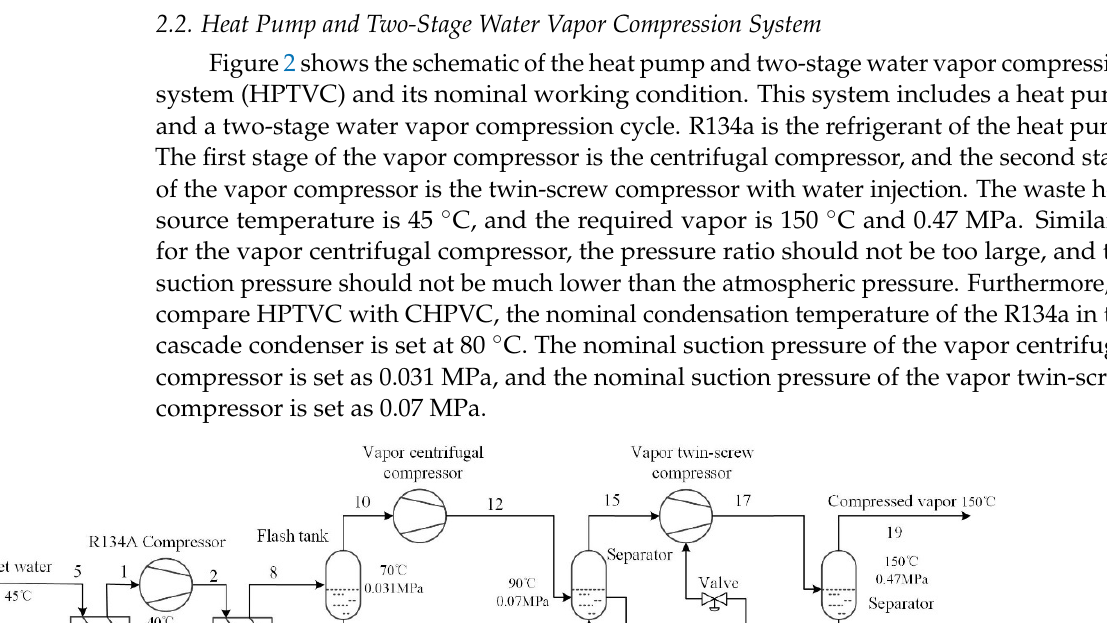
Figure 1. Schematic of CHPVC.